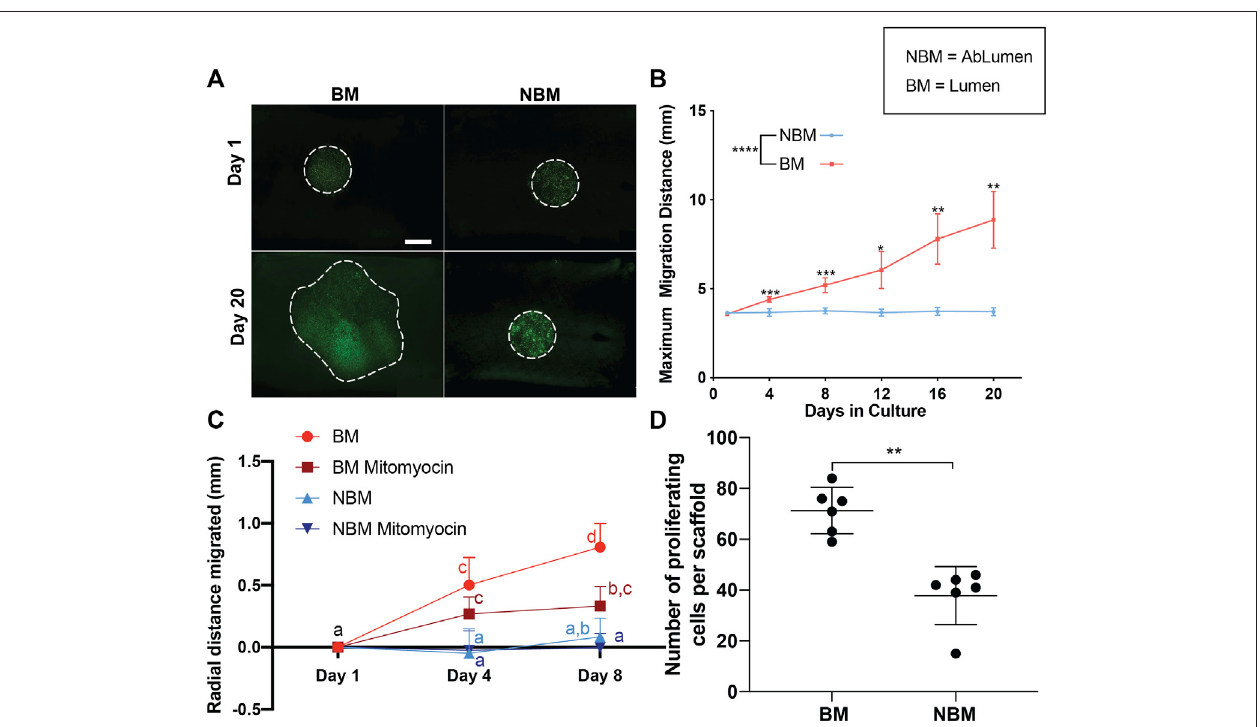
FIGURE 2 | Effects of the presence (BM) versus the absence (NBM) of basement membrane proteins on human aortic endothelial cell (hAECs) migration and proliferation. Inverted microscopyimages ofGFP-labeled hAECsdemonstrate thatcellsseededon theBMsurface coveralargersurfaceareathan thoseseeded onthe non-basement membrane protein (NBM) surface following 20 days in culture (A) . Dashed lines for Day 1 images indicate the initial seeding location of the cells. Dashed lines on Day 20 images indicate the fi nal location of the cells. Due to the uneven surface of the scaffolds and the imaging method (stitch function in microscope Nikon Eclipse Ts2R),different values of cell brightness and focusare present in the images. Aquantitative analysis ofcell migration distanceshows asigni fi cant increase in the maximal migration distance for cells seeded on the BM surface versus the NBM surface at all post-seeding timepoints (B) . Analysis of cell migration only (i.e., proliferation inhibited with mitomycin) shows a signi fi cant difference in the maximal radial distance migrated by treated-hAECs seeded on the BM surface (BM mitomyocin)whencomparedtotreated-hAECsseededontheNBMsurface(NBMmitomyocin)atalltimepoints (C) .Groupsnotconnectedbythesamelowercaseletter aresigni fi cantlydifferent.Maximalmigratorydistancefollowing9 daysofculturewasreducedbytheadditionofmitomycinforcellsseededontheBMsurface,butnotfor thoseseededontheNBMsurface (D) Assessmentofproliferationonly(i.e.,FUCCIstaining)demonstratedasigni fi cantlyhighernumberofproliferatinghAECsontheBM surface when compared to the cells in the NBM surface (D) . Scale bar A, 5,000 µm * = p < 0.05, ** = p < 0.01, *** = p <